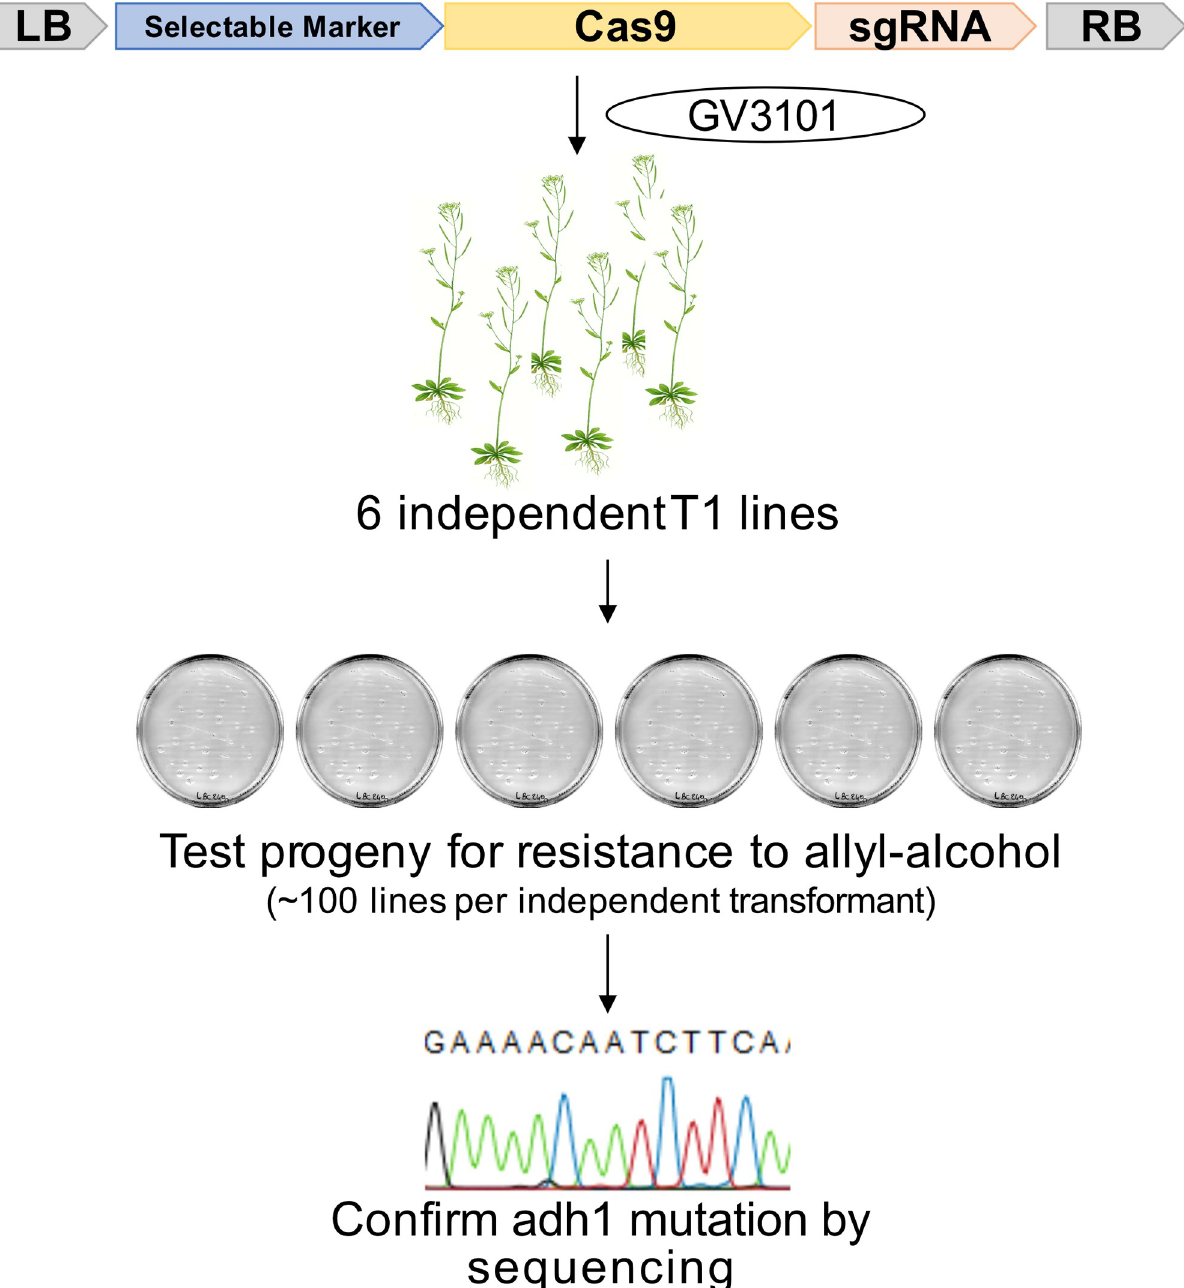
Fig 2. Evaluation of mutation rates. Constructs were transformed into Arabidopsis accession Col-0 via Agrobacterium tumefaciens strain GV3101. Six independent transformants (T1) were selected using Glufosinate. About 100 progeny (T2) of each transformant were selected for allyl-alcohol resistance. For each independent T2 family, up to six allyl-alcohol resistant plants were genotyped at the ADH1 locus. For each T2 family, the mutation rate was calculated as [(number of allyl-alcohol surviving plants) x (% of homozygous or biallelic mutants confirmed by sequencing among the surviving plants tested) / (number of seeds